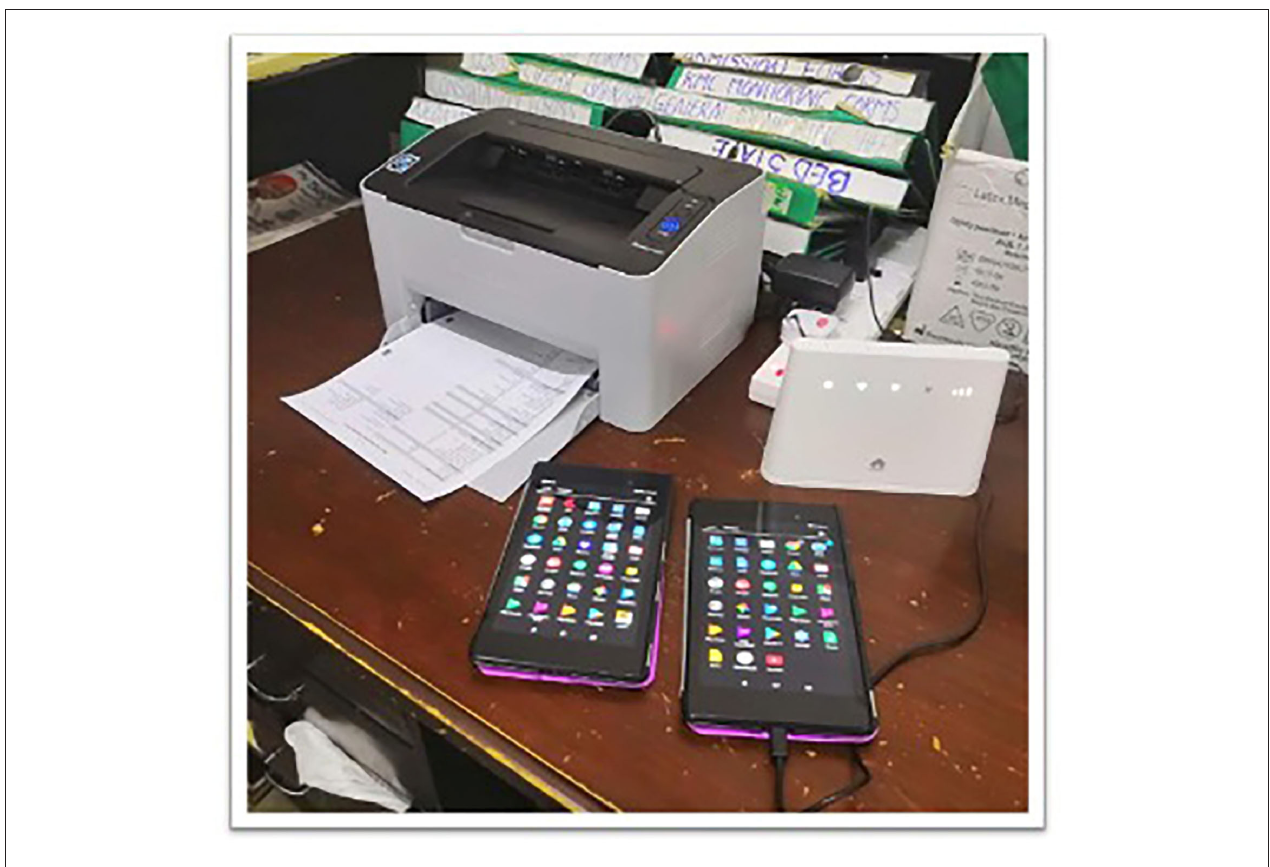
FIGURE 6 | NeoTree